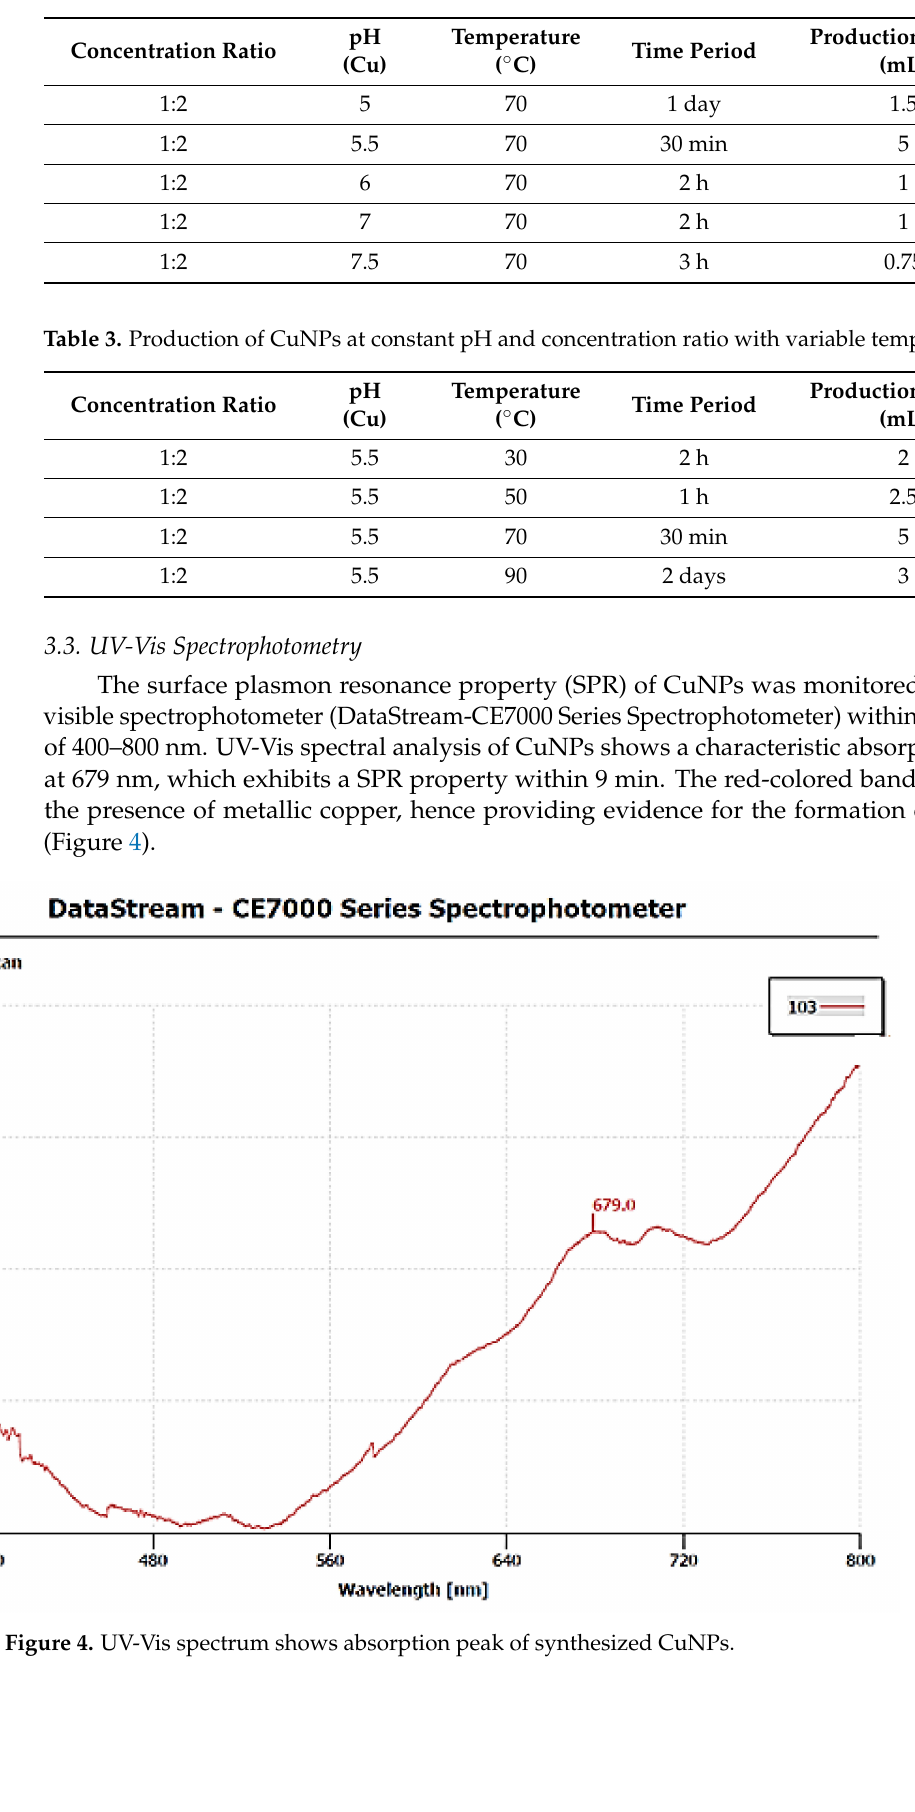
Table 2. Production of CuNPs at constant concentration ratio and temperature with variable pH.